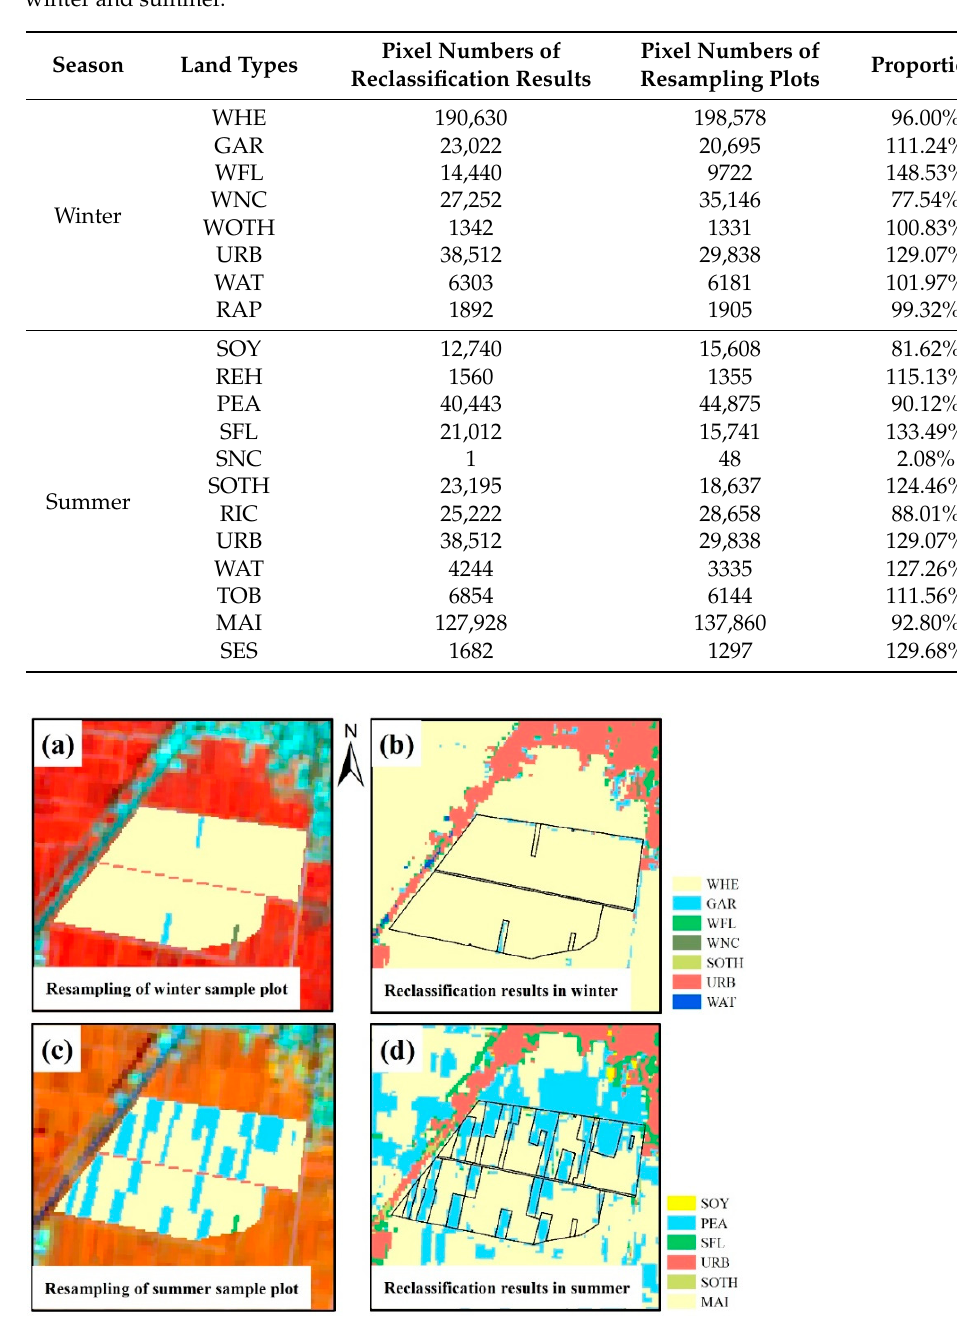
Figure 10. Resampling and reclassification results in both seasons.